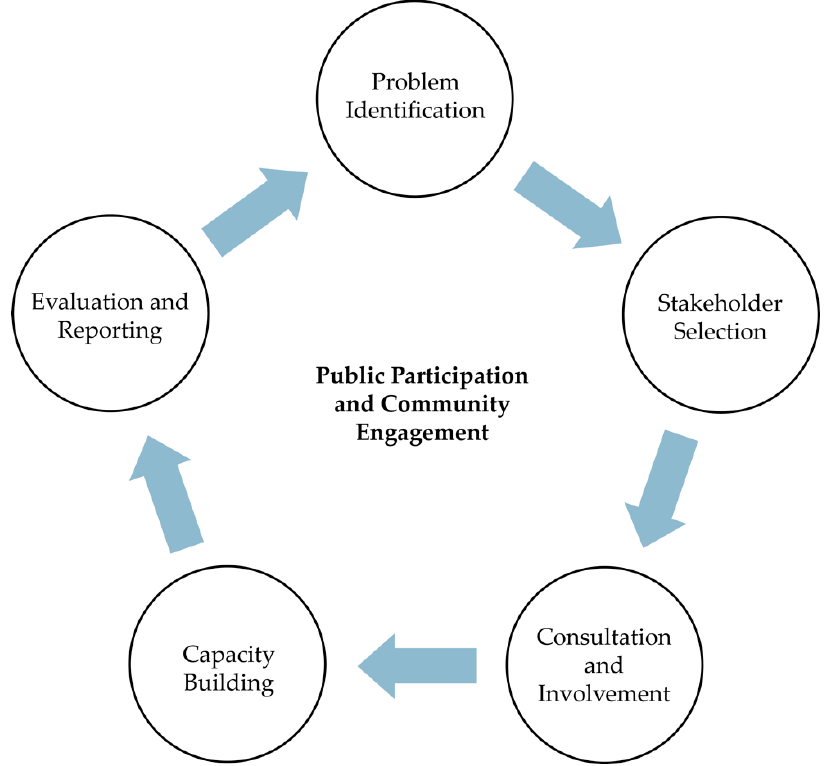
Figure 3. Public Participation and Community Engagement Methodology (Based on Krick et al., 2005 [51]).